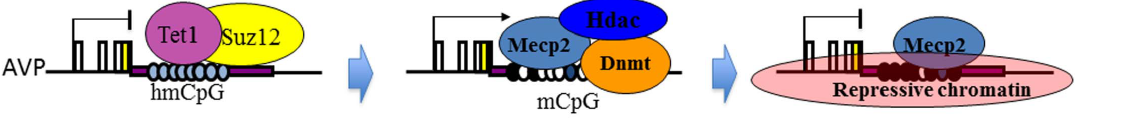
Figure 8. Model for the formation of early-life stress responsive DNA methylation. In the undifferentiated state, Tet1 and polycomb complexes (for the sake of simplicity symbolized by the histone methyltransferase Suz12) bind to the Avp enhancer and confer gene